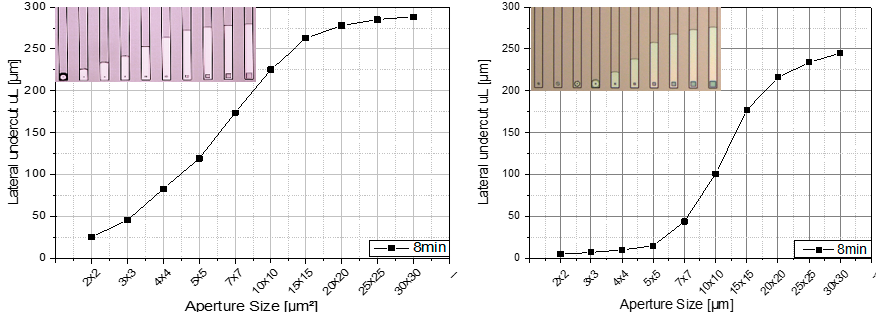
Figure 3. The etch results after 8 min for XeF 2 ( left ) and SF 6 ( right